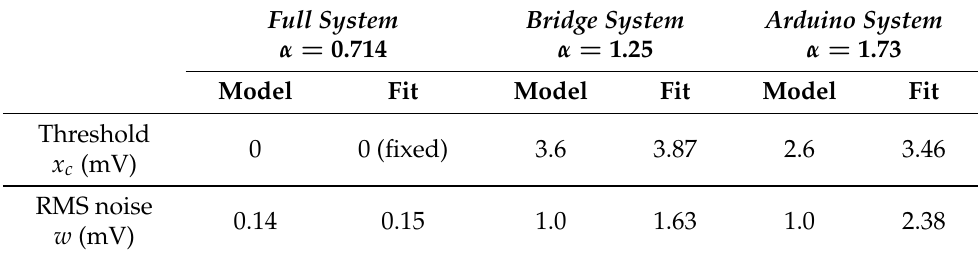
Table 1. Parameters used for the model and fit in